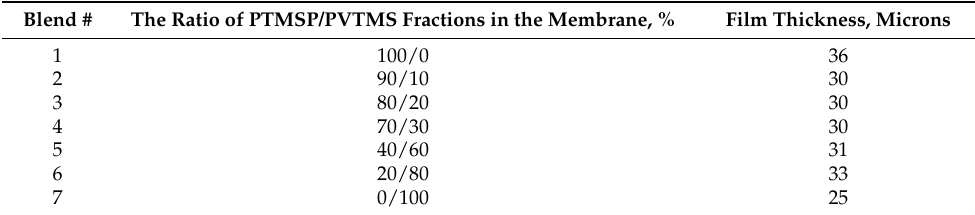
Table 2. Composition and thickness of the studied polymer blend